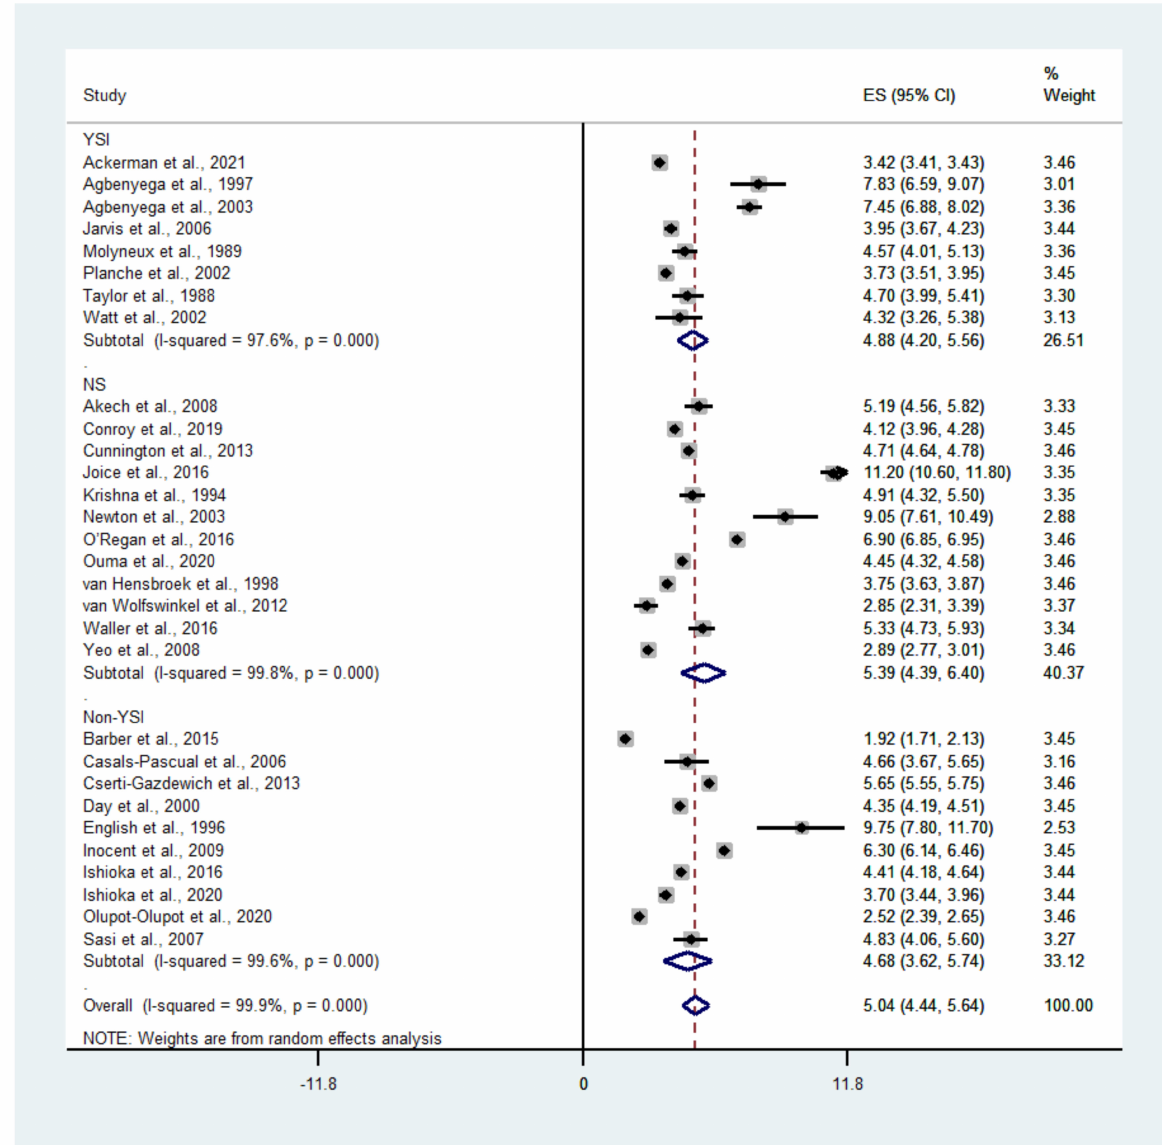
Figure 4. Mean lactate level in patients with severe malaria determined by different analyzers. Abbreviations: ES, estimated mean lactate; CI, confidence interval; NS, not